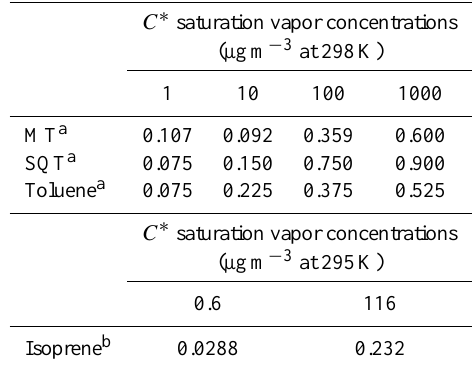
Table 3. Low-NO x SOA yield parameters using basis sets, used to estimate SOA yields from VOCs in the OFR (Sect.